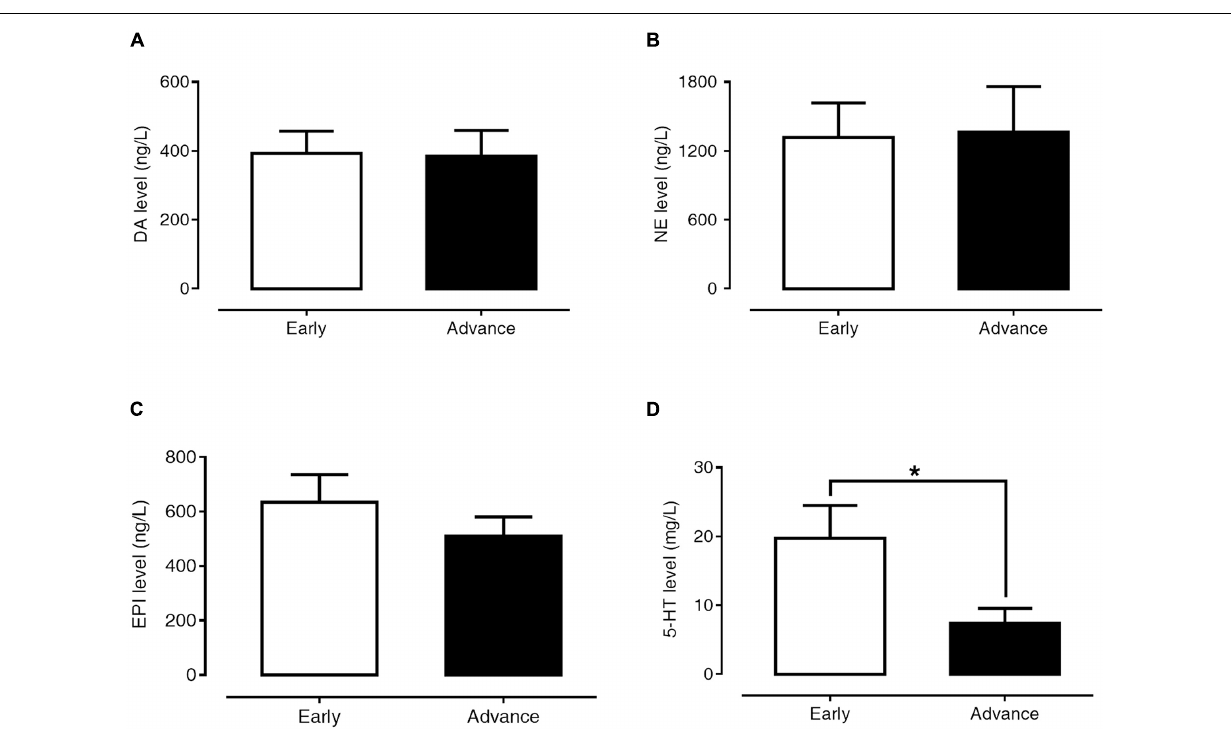
Frontiers in Neuroscience |